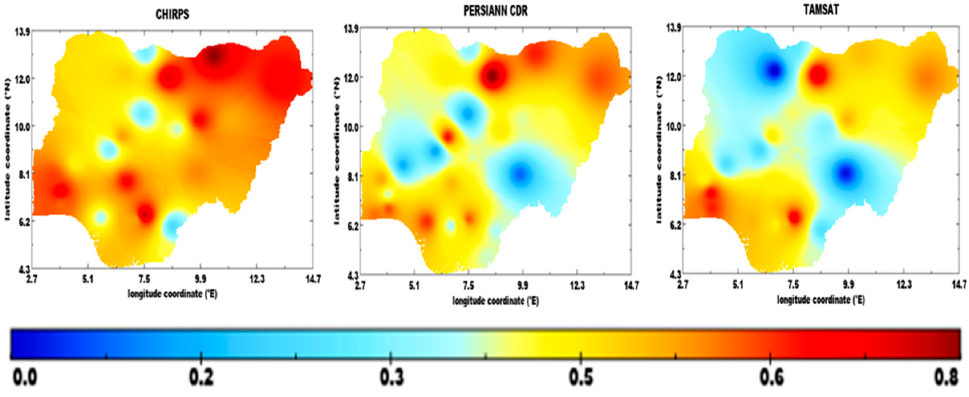
Figure 9. Correlation coe ffi cient of annual rainfall (mm / year) over Nigeria.